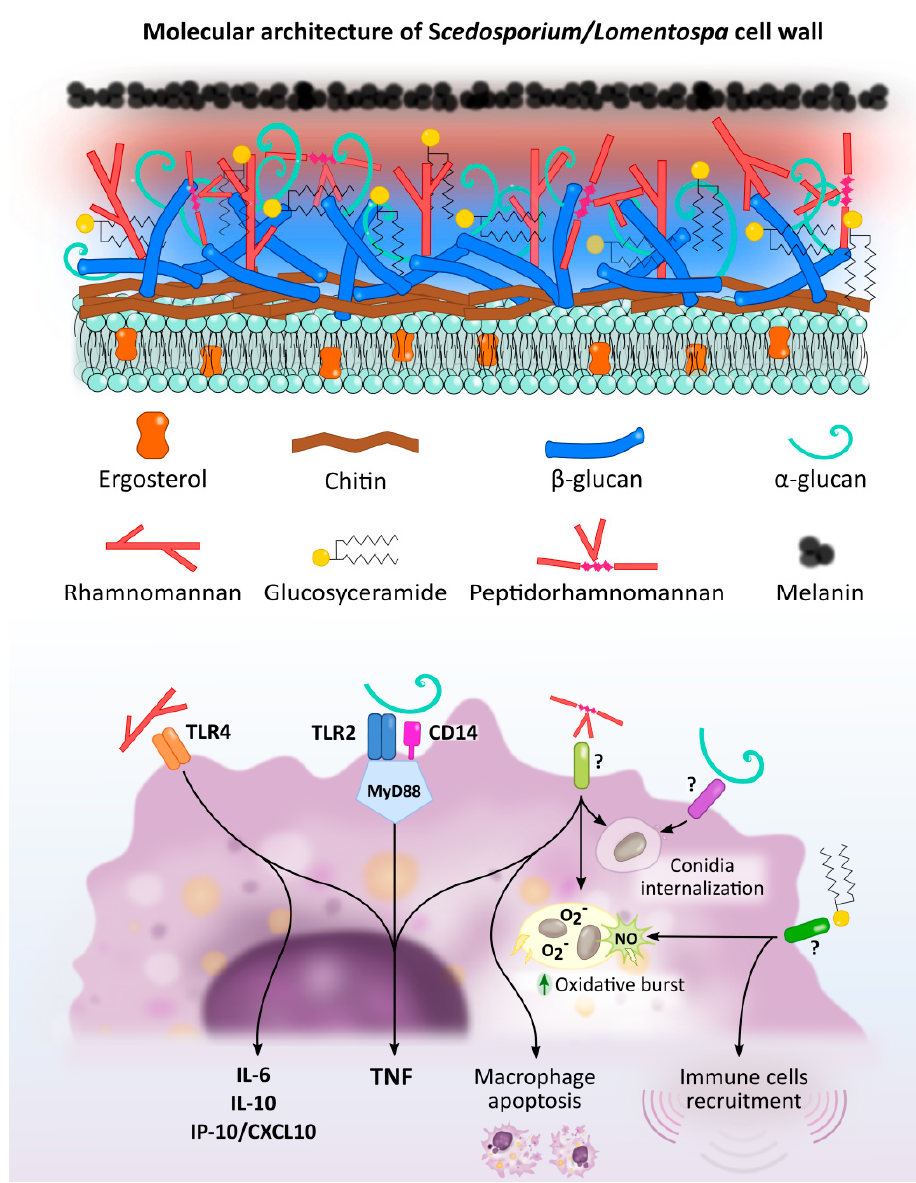
Figure 1. Scedosporium / Lomentospora cell wall components induced macrophage activation and Pattern Recognition Receptors (PRR) involved in these interactions. Rhamnomannans binds to TLR4 stimulating TNF, IL-6, IL-10 and IP-10/CXCL10 release. α -glucans stimulates TNF release through TLR2, CD14 and MyD88. It is also involved in conidia uptake, but the receptor involved in this process is unknown. Peptidorhamnomannan (PRM) is involved in fungal phagocytosis, induces macrophages death, and stimulates production of TNF, nitric oxide (NO) and superoxide (O 2 − ). Glucosylceramide (GlcCer) induces NO and superoxide O 2 − production, increases fungal conidia killing, and promotes the recruitment of immune cells, including macrophages. The GlcCer and PRM receptor/s implicated in this activation have not been elucidated.